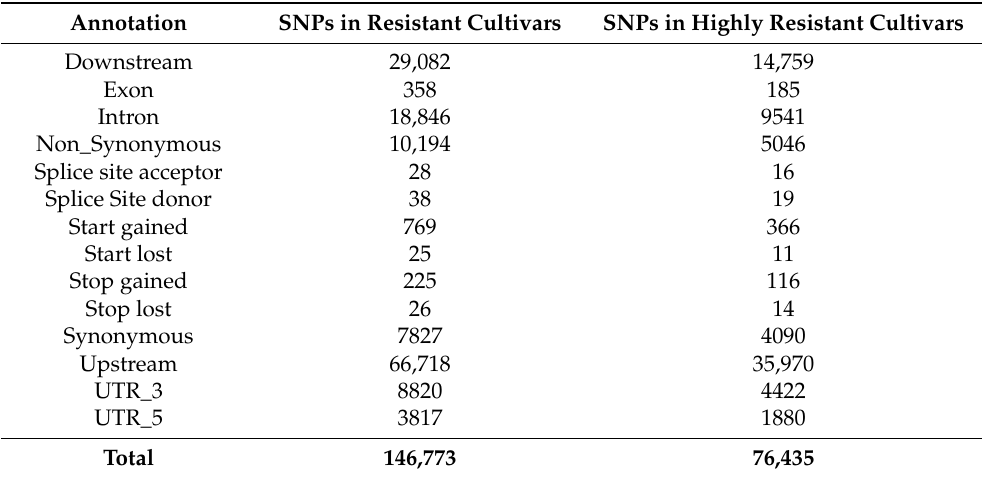
Table 2. Distribution of the heat stress-tolerant SNPs in the rice pan-genome.